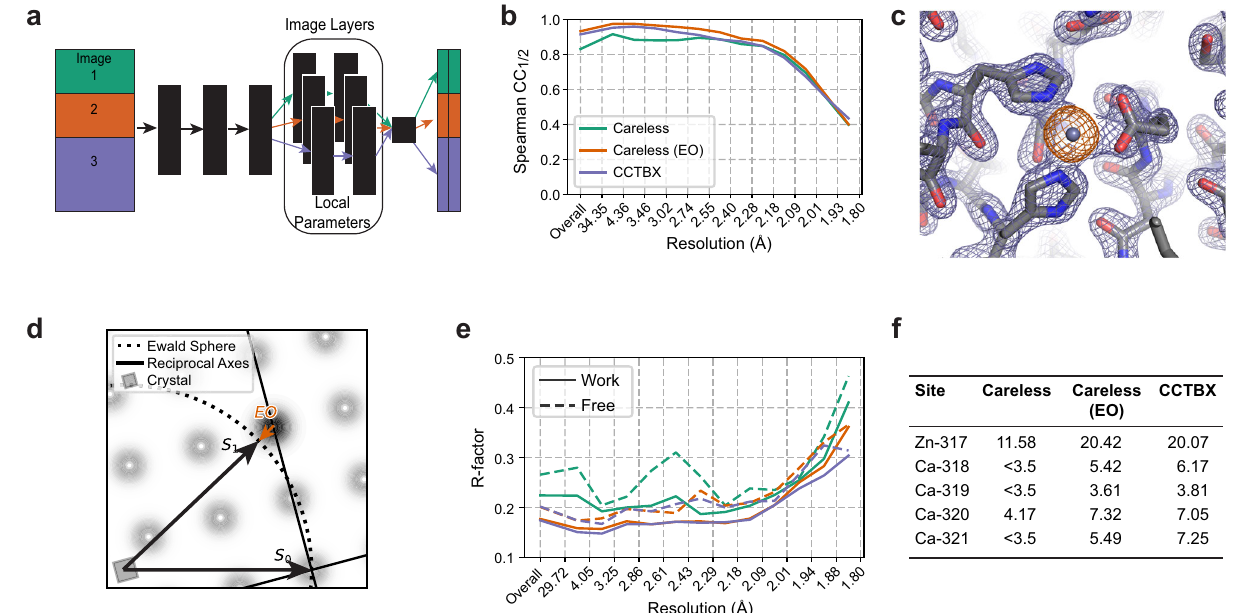
Fig. 5 | Careless can leverage geometric metadata to improve XFEL data pro- cessing.a Byaddingimage-speci fi clayerstotheneuralnetwork,Carelesscanscale diffraction data from serial XFEL experiments. b The Ewald offset (EO), shown in red, can optionally be included during processing. S 0 and S 1 represent the direc- tions of the unscattered and diffracted X-rays, respectively. c Half-dataset corre- lation coef fi cients by resolution bin for data processed in Careless, with and